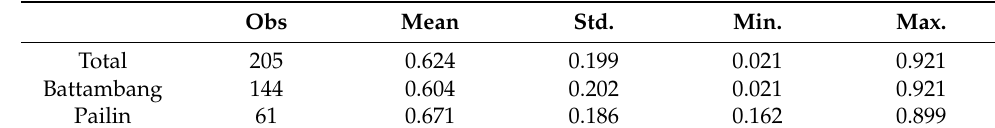
Table 3. Technical efficiency scores summary.